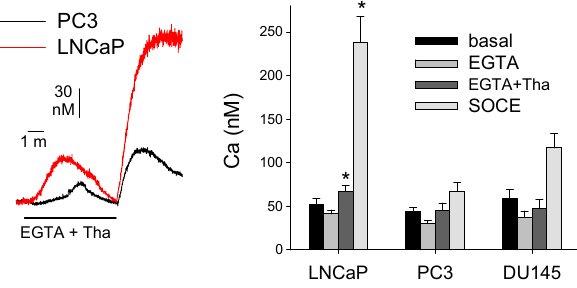
Figure 2: [ Ca 2 + ] i level in the three cell lines following treatment with thapsigargin ( 1 µM, Tha ) in 0 Ca EGTA ( EGTA ) and in control Ca 2 + ( 1 mM ) . Traces on the left show two representative experiments, in PC3 ( black trace ) and LNCaP ( red trace ) cells, respectively. The [ Ca 2 + ] fi cantly, when i level decreased slightly, but not signi switching from basal external Ca 2 + ( 1 mM ) to 0 Ca - EGTA in all cell types. Following thapsigargin application in 0 Ca - EGTA bath, [ Ca 2 + ] i rise was larger in LNCaP than PC3 and DU145 and [ Ca 2 + ] i level was signi fi cantly di ff erent from basal level only in these cell type. When external Ca 2 was restored to 1 mM, [ Ca 2 + ] i increased as a conse - quence of SOCE and this response was more pronounced in LNCaP cells than in the other cell lines. Lines represent SEM over the number of experiments, which were LNCaP and PC3 n = 16, DU145 n = 10. ( * ) indicates signi fi cantly di ff erent from basal Ca level p < 0.001 by paired t -